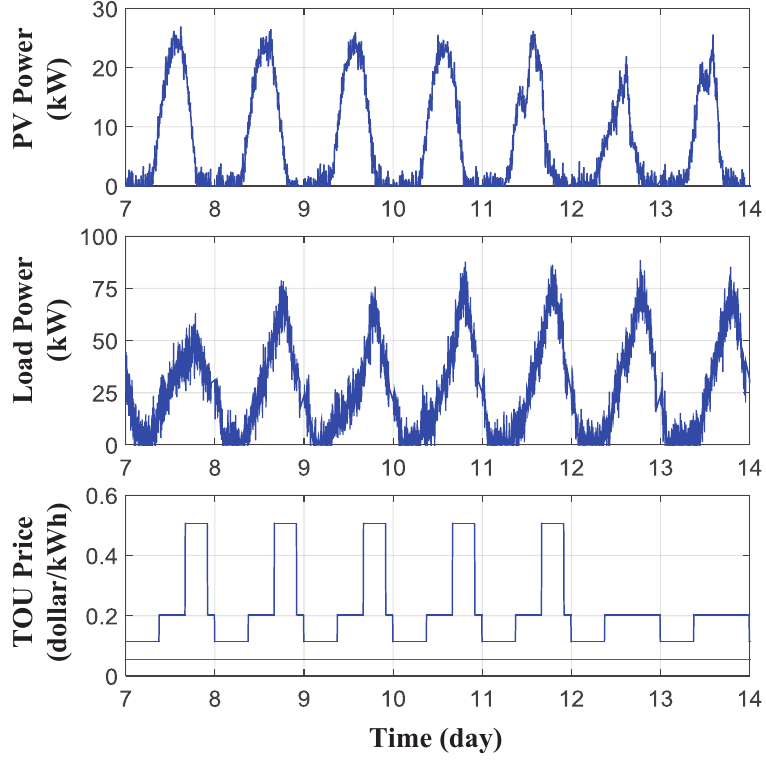
Figure 8. Zoomed in profiles of annual PV and load